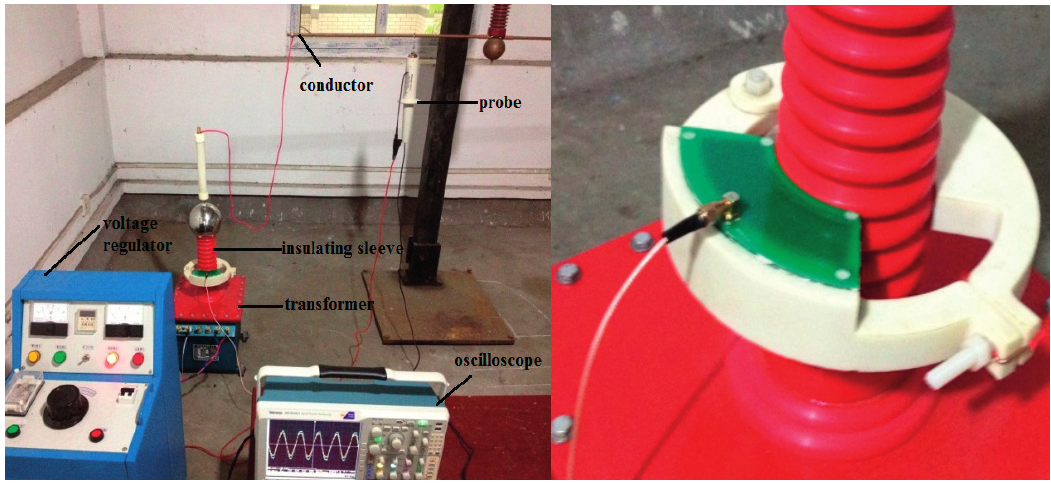
Figure 17. Experimental platform.